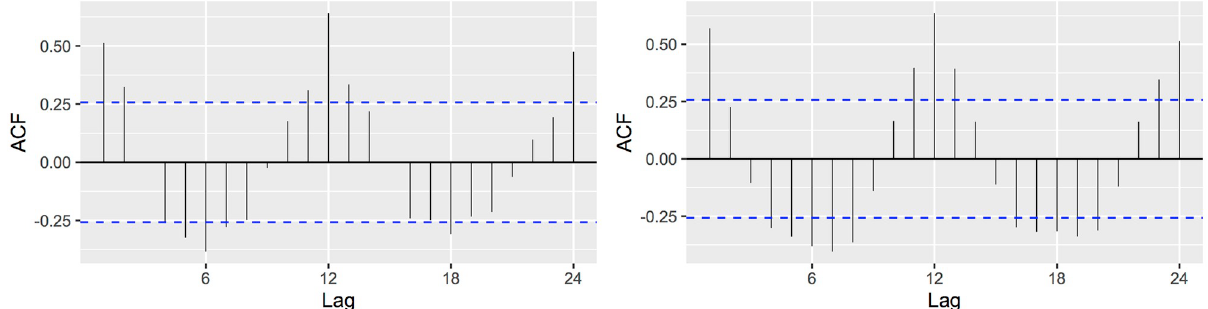
Fig 1. Correlograms of the series of total deaths from January 2015 to December 2019 of Brazil and Spain. Left hand side corresponds to Brazil and the right hand side corresponds to Spain. Lag units in months.